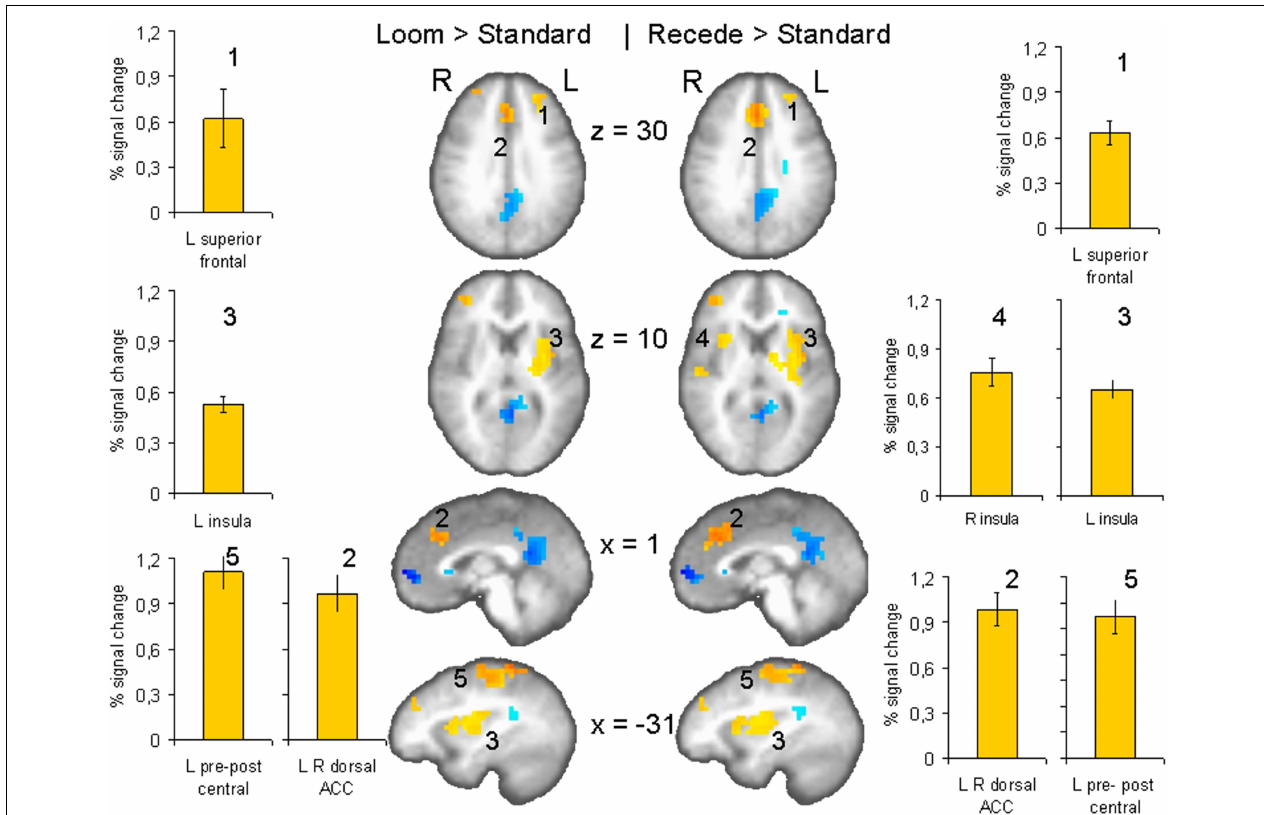
(row 3 and 4); percent signal change is plotted (mean; SEM) as obtained through t -tests ( P < 0.001, corrected). Numbers in slices correspond to numbers in bar charts representing average percent signal change in specifi c regions of